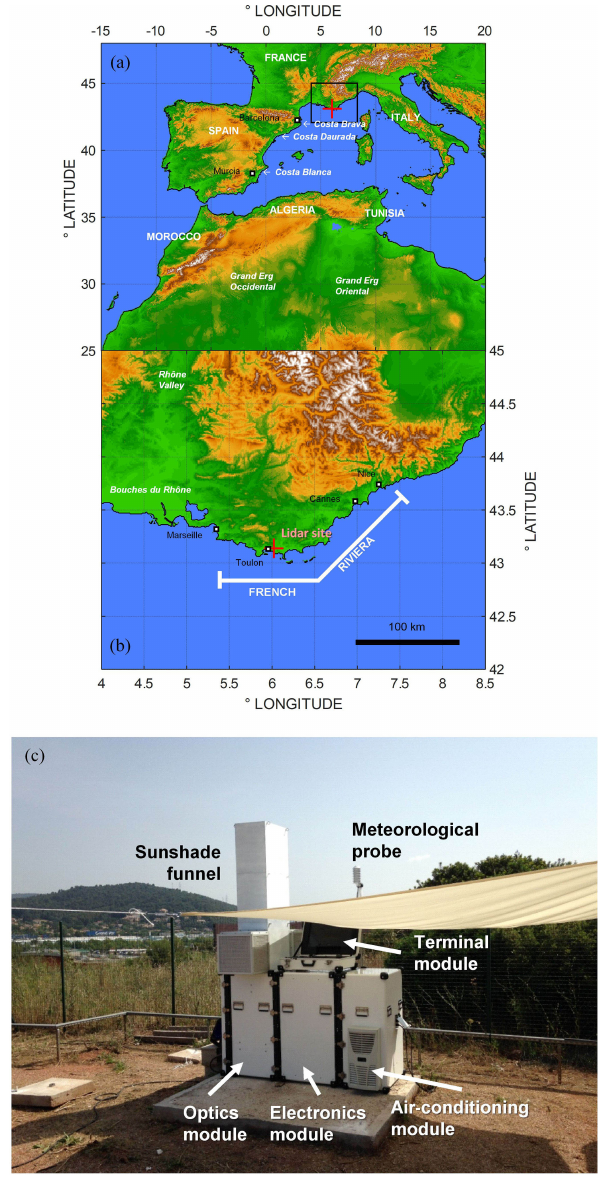
Figure 1. (a) Map of the western Mediterranean basin and (b) crop showing the location of the lidar at the Toulon–La Garde AERONET site on the French Riviera (elevation data from the GTopo30 DEM, courtesy of USGS). (c) Lidar in its confinement during the field